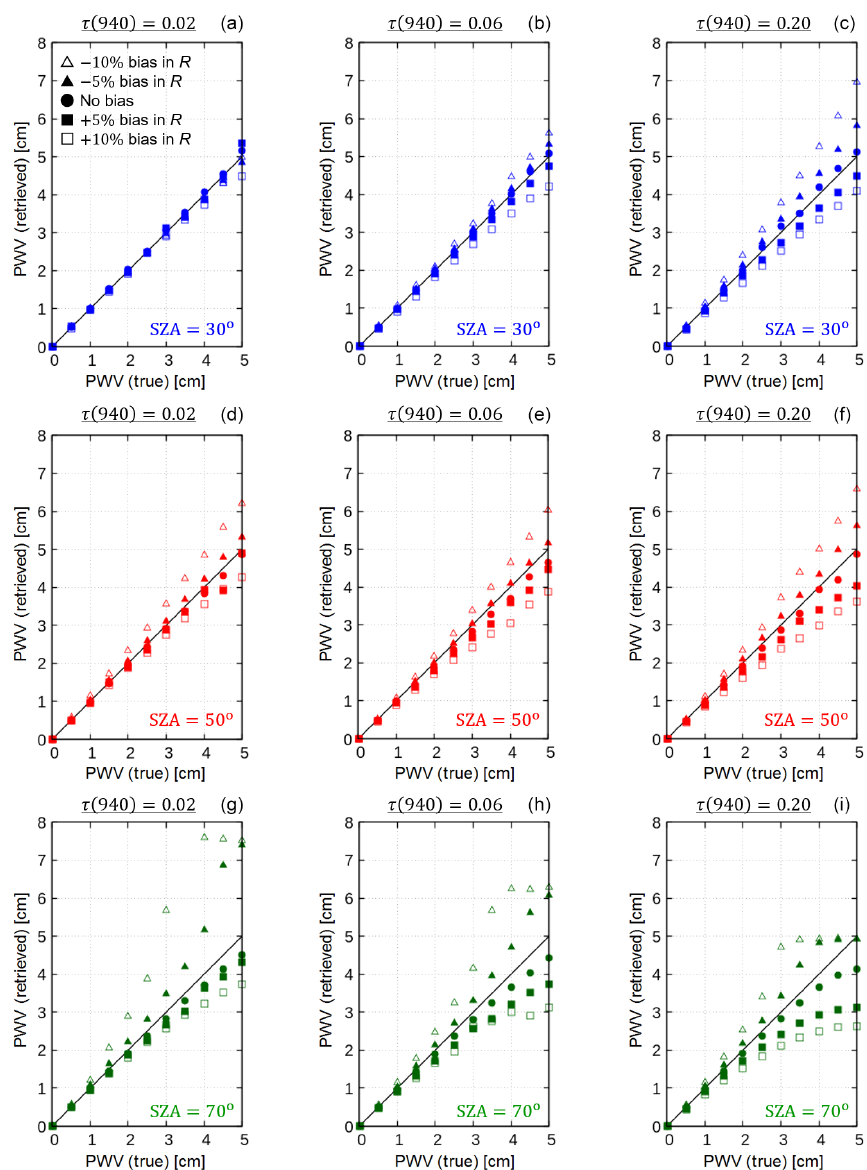
Figure 13. Comparison of the true and retrieval values of PWV from simulated data for continental-average aerosol with bias errors. The top, middle, and bottom rows are the retrieval results at SZA = 30, 50, and 70 ◦ , respectively. Closed circles are the results with no bias errors. Closed squares and closed triangles are the results with bias errors of plus and minus 5% in R , respectively. Open squares and open triangles are the results with bias errors of plus and minus 10% in R ,